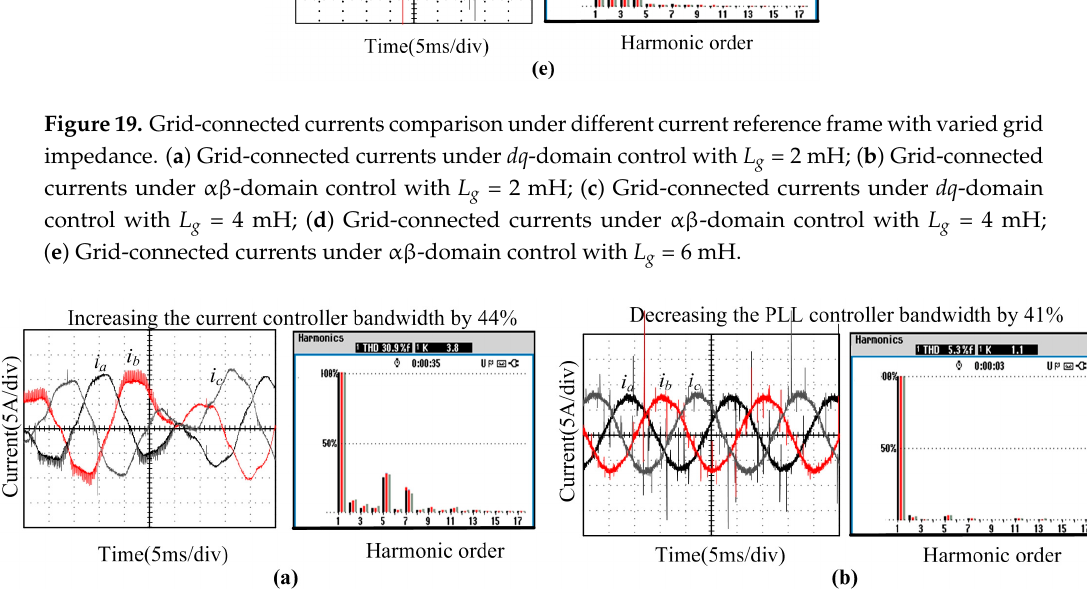
Figure 20. Grid-connected currents comparison under different control parameters with varied grid impedance. ( a ) Grid-connected currents under current controller regulating with L g = 6 mH; ( b ) Grid-connected currents under PLL controller regulating with L g = 6 mH.